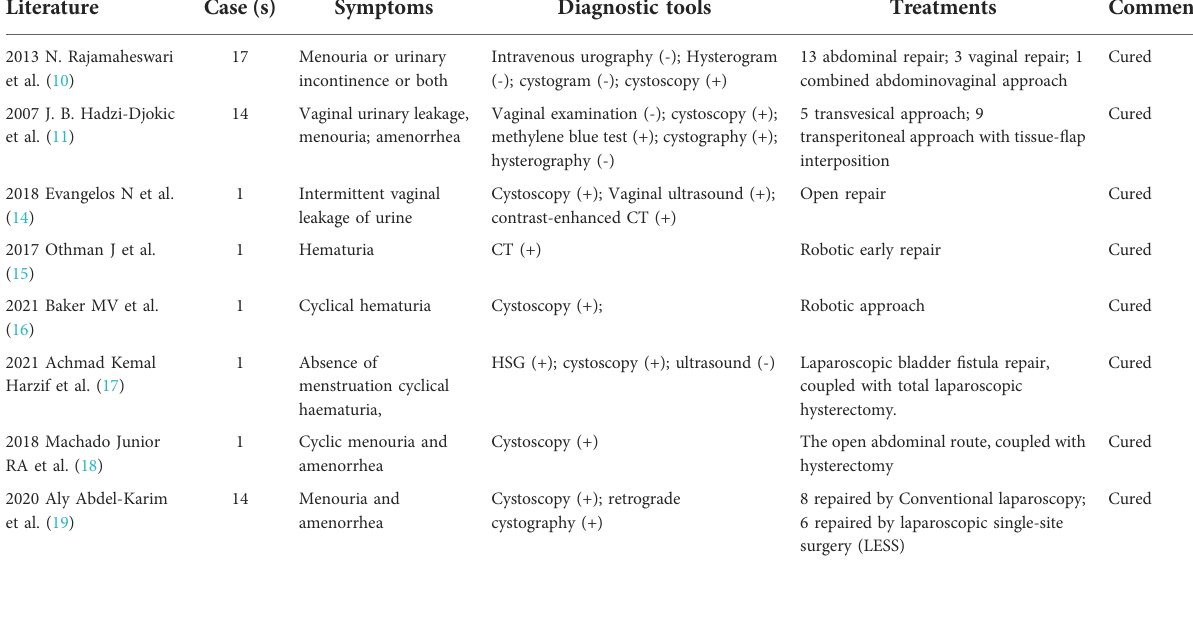
TABLE 1 Review of the literature with CERVICOVESICAL